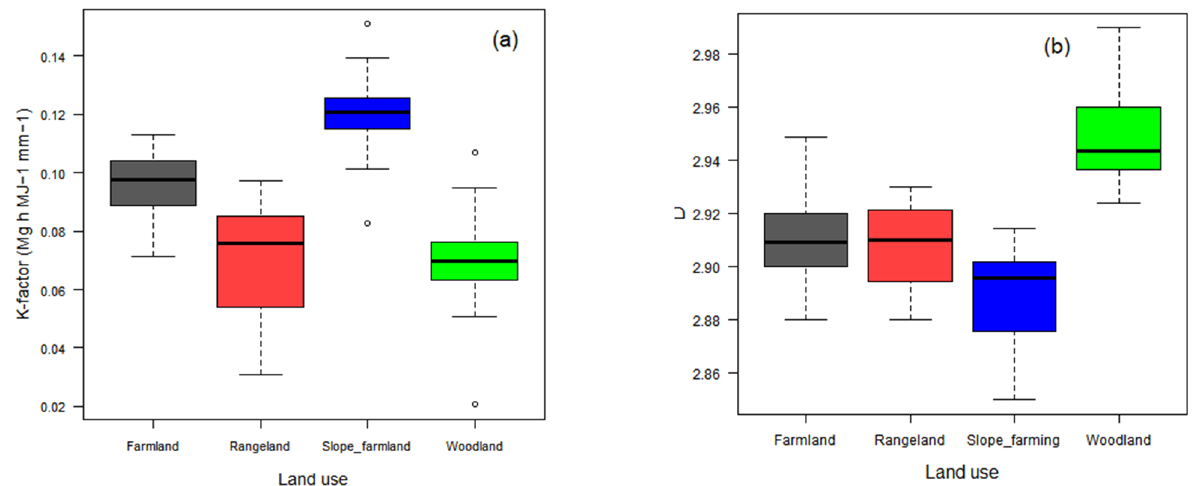
Figure 6. Summary box plots of ( a ) K- factor and ( b ) D, under different land-use ( n =